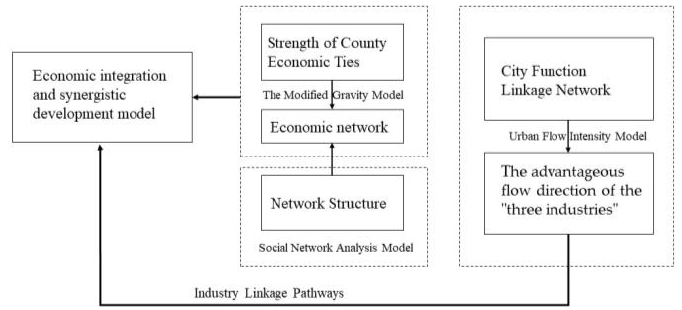
Figure 2. Research logic diagram.